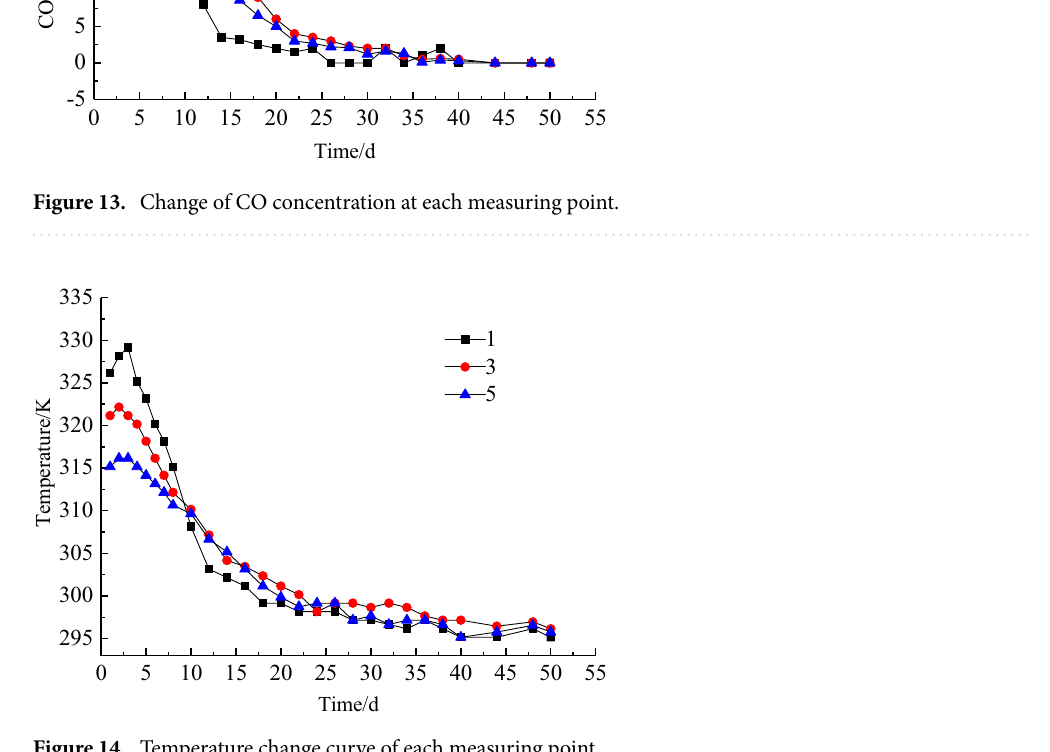
Figure 14. Temperature change curve of each measuring